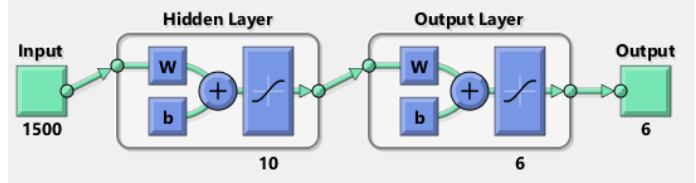
Figure 15. NET2_STATE neural network diagram